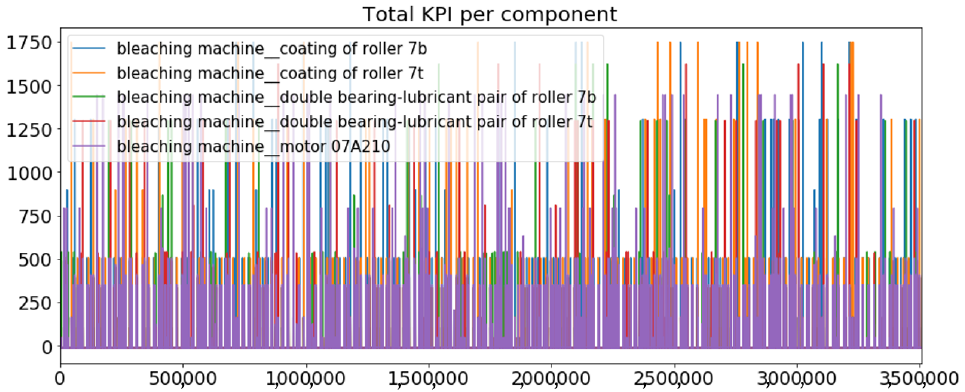
Figure 14. Total KPI time series yielded from running the model with paired coated rollers for the bleaching machine (ZORLUTEKS). The simulation interval has the same length as for training (200 years).